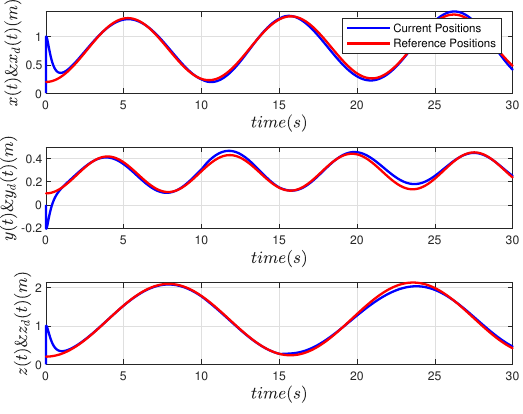
Figure 8. UAV’s Position Tracking Performance: SM.